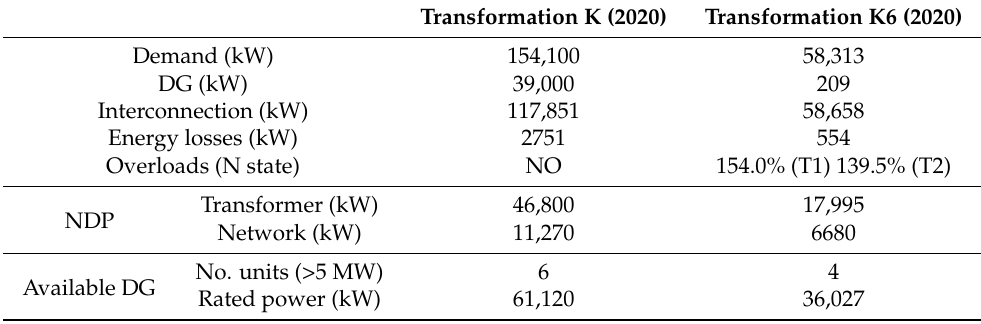
Table 3. Transformations K and K6 power flow and contingency analysis results for 2020 planning.